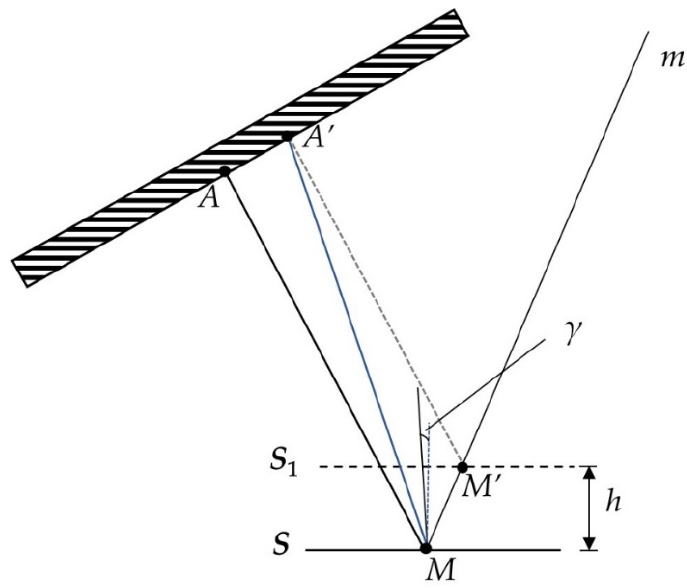
Figure 1. Effect of phase error.